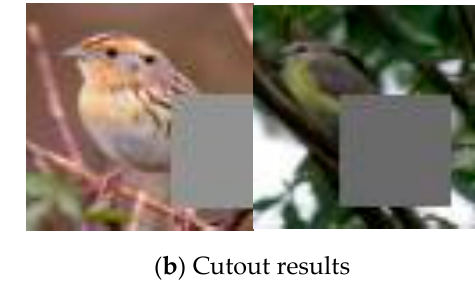
Figure 2. Cutout processing.